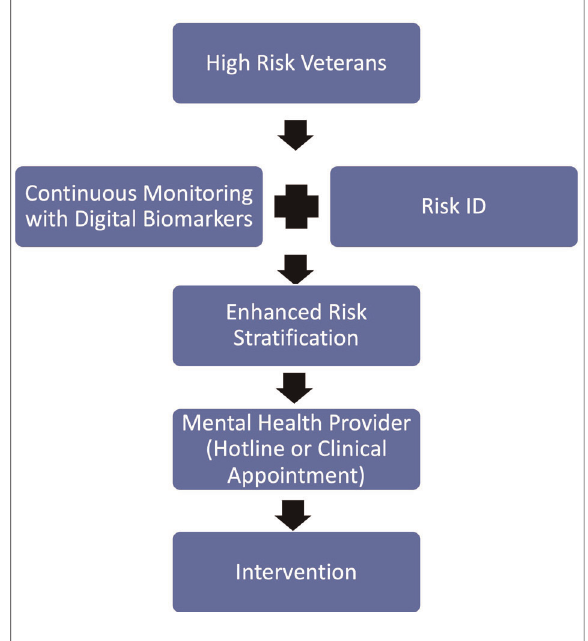
FIGURE 2 Proposed new method of screening Veterans for suicide risk which combines continuous monitoring via digital biomarkers with the current Risk ID process in order to enhance risk detection and strati fi